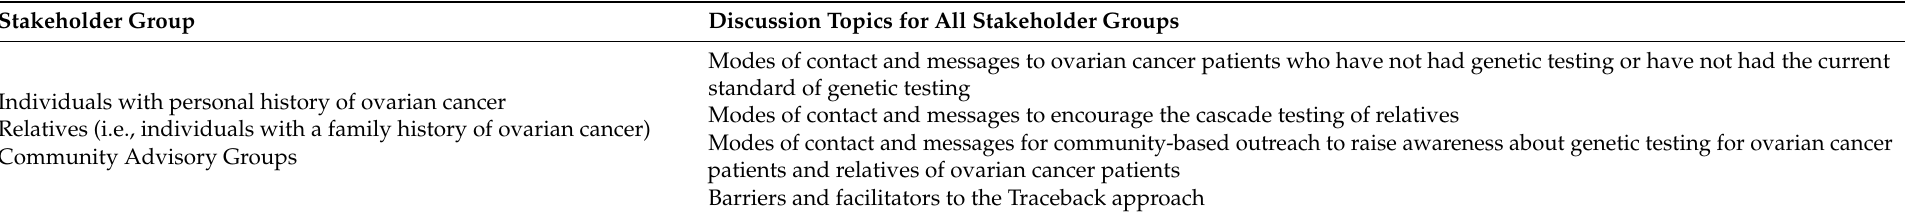
Table 2. Stakeholder groups and discussion topics explored in Aim 2